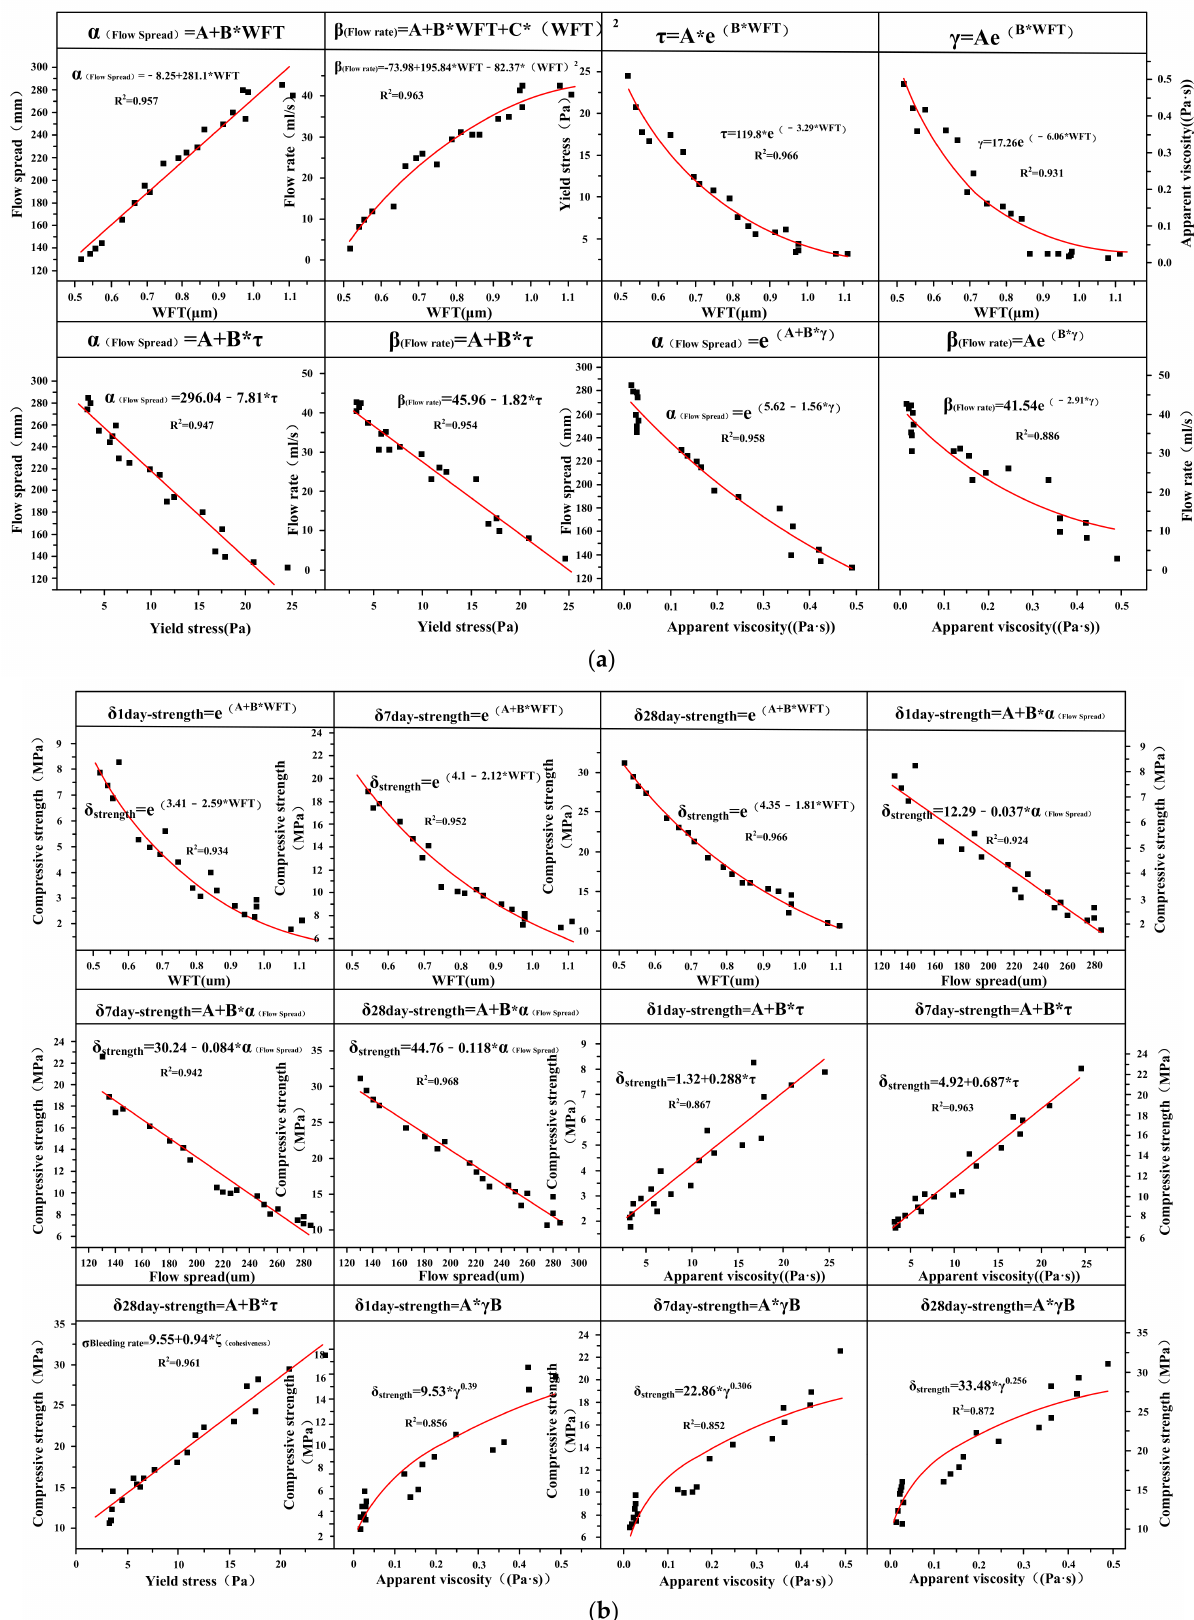
Figure 18. Mathematical empirical model verification ( a , b ): ( a ) The mathematical empirical models between WFT and fresh properties; ( b ) The mathematical empirical models between WFT, fresh properties and compressive